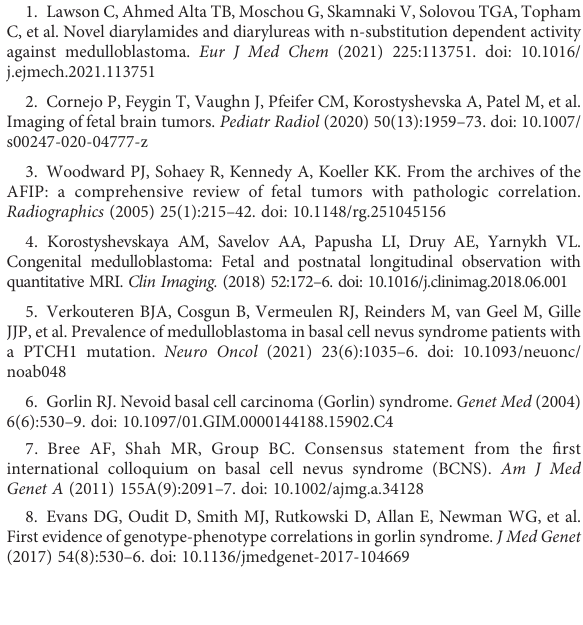
SUPPLEMENTARY FIGURE 1 MRI fi ndings for Patient two. MRI showed a large pathological mass in the posterior fossa, very similar to the imaging for Patient 1. (A) Axial T1 images. (B) Sagittal T1 images. SUPPLEMENTARY FIGURE 2 Postoperative review and pathological results for Patient one. The tumor was gray – white, fi sh-like, and had an abundant blood supply (A) . Postoperative CT and MRI showed complete tumor resection (B – D) . HE staining (E, F) . SUPPLEMENTARY FIGURE 3 Pedigree of the family. SUPPLEMENTARY FIGURE 4 Distribution of mutations in Patient one depicted by a Circos diagram. SUPPLEMENTARY FIGURE 5 The treatment of Patient one in